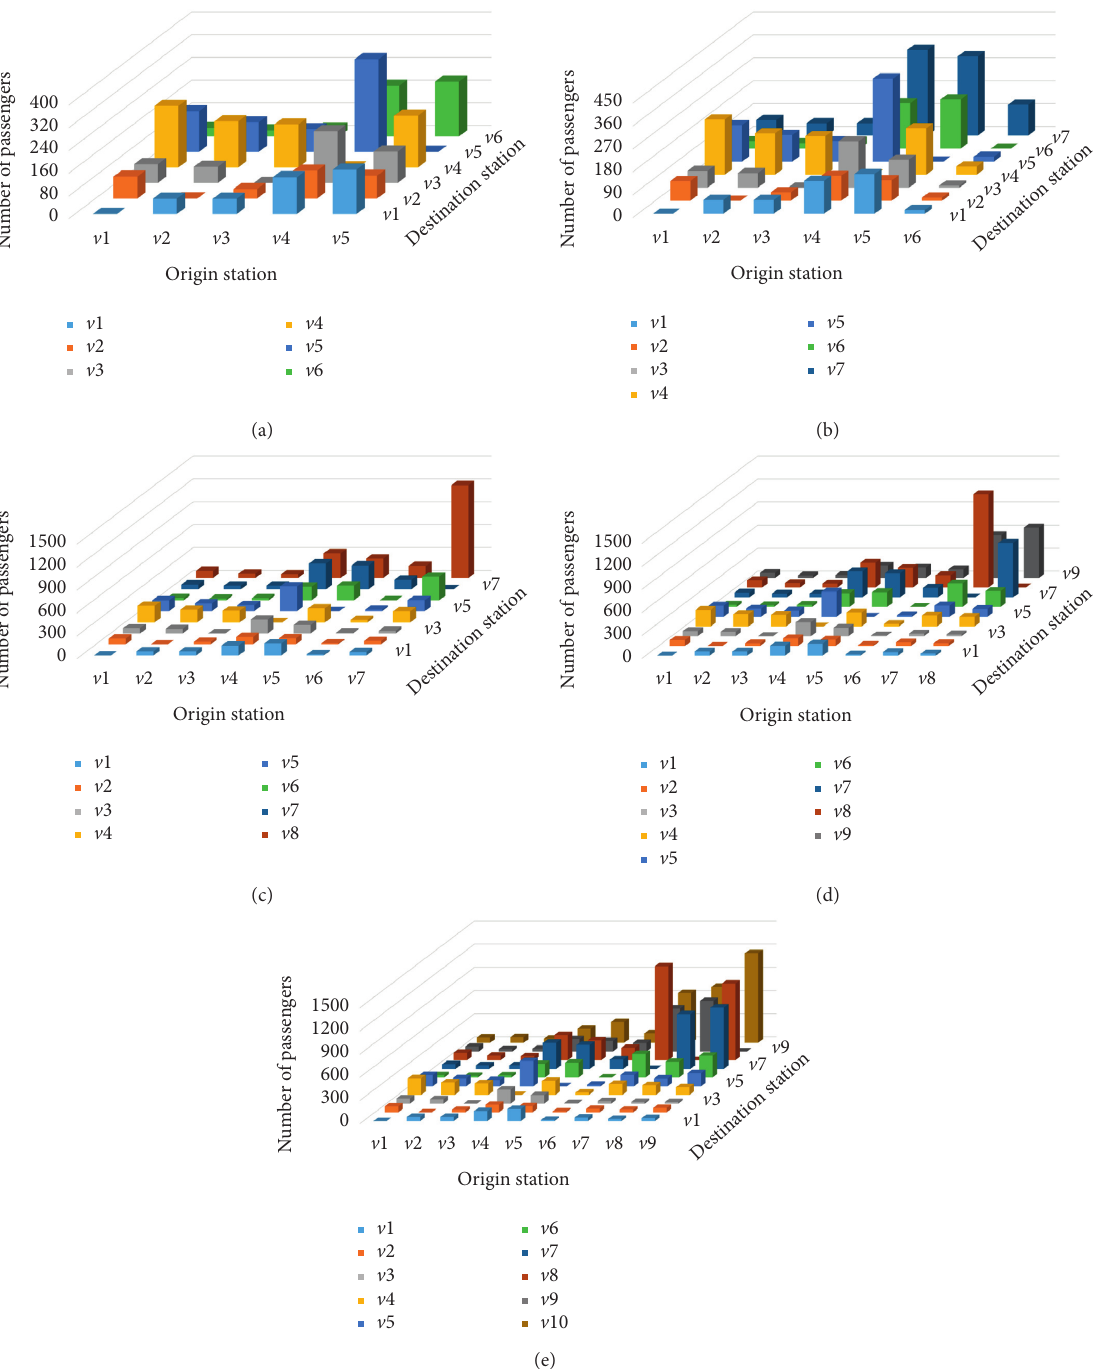
Figure 5: Passenger OD matrices of 5 lines. (a) Six-station OD demand. (b) Seven-station OD demand. (c) Eight-station OD demand. (d) Nine-station OD demand. (e) Ten-station OD